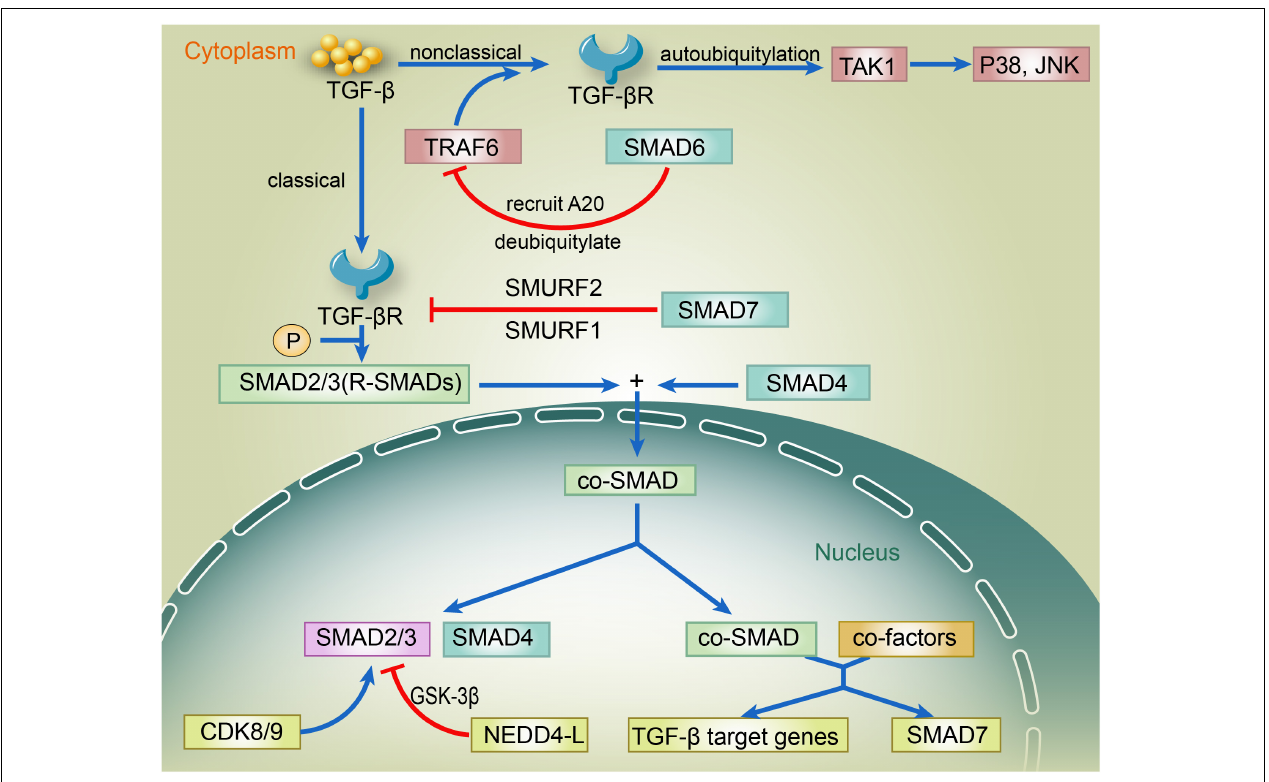
FIGURE 1 | The regulation of TGF- β via canonical and non-canonical pathways. In the canonical pathway, binding of TGF- β ligand to TGF- β R induces the phosphorylation of SMAD2/3. Phosphorylated SMAD2/3 forms a complex with SMAD4 and then translocates to the nucleus. Once it enters the nucleus, the SMAD2/3–SMAD4 complex binds to other transcriptional co-factors, which initiates the transcription of TGF- β target genes and the expression of SMAD7. SMAD7 recruits SMURF1 and SMURF2 to the TGF- β R and induces its proteasome-dependent degradation, which eventually weakens the TGF- β signaling. Inside the nucleus, the linker region of SMAD2/3 is phosphorylated by CDK8 and CDK9, enhancing the TGF- β signaling by promoting the binding of SMAD2/3 to other transcriptional coactivators. The GSK-3 β -phosphorylated SMAD2/3 can be recognized by NEDD4-L and then undergo the ubiquitin-mediated degradation, thereby attenuating the TGF- β signaling. In the non-canonical pathway, binding of the TGF- β ligand to its receptor promotes the binding of TRAF6 to the TGF- β Rs. TRAF6-induced autoubiquitylation of TGF- β Rs activates TAK1, which further triggers the downstream p38 and JNK pathways. TGF- β , transforming growth factor β ; TGF- β R, TGF- β receptor; SMAD; SMURF, SMAD ubiquitylation regulatory factor; CDK, cyclin-dependent kinase; GSK-3 β , glycogen synthase kinase-3 β ; NEDD4-L, neural precursor cell expressed developmentally down-regulated 4-like; TRAF6, TNF receptor-associated factor; TAK1, transforming-growth-factor- β -activated kinase; JNK, c-JUN N-terminal